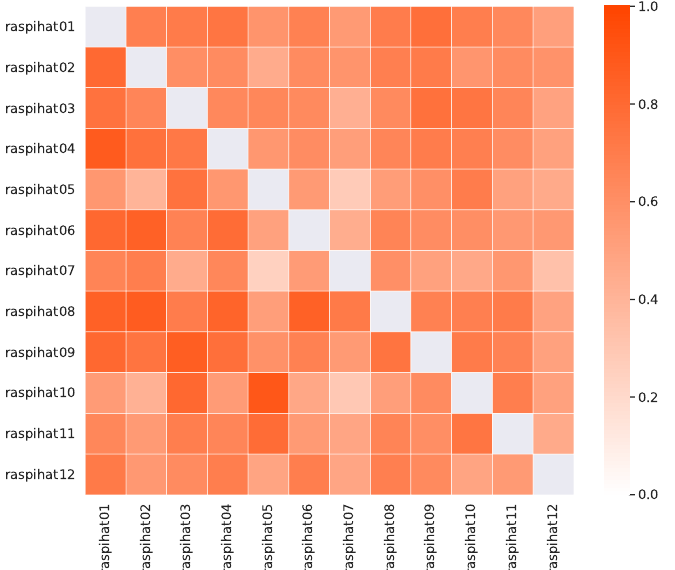
Figure 3. Pearson (lower triangular part) and Kendall (upper triangular part) correlation values among the recorded